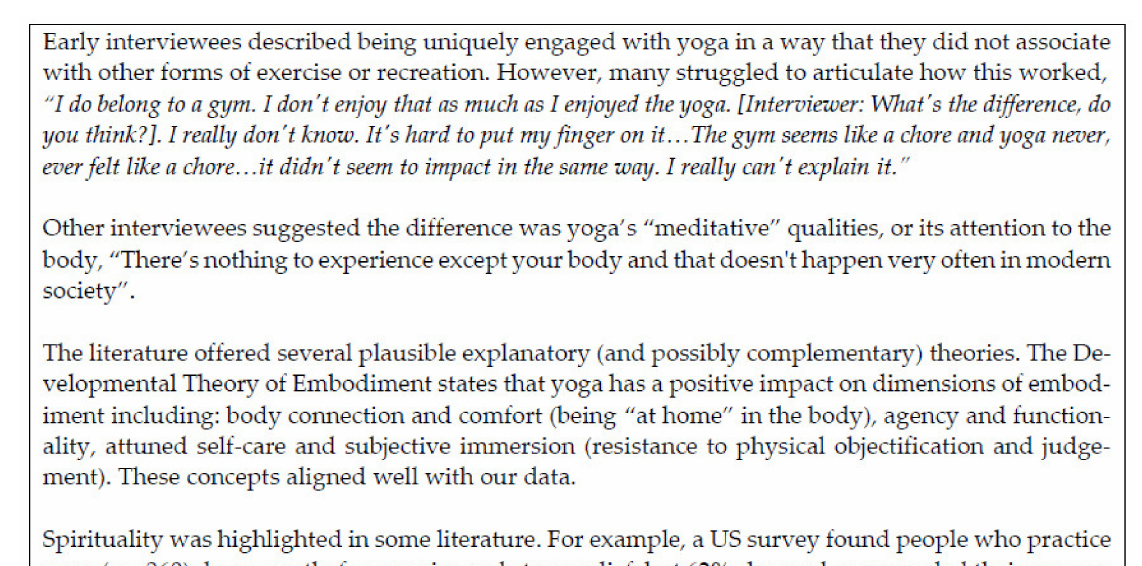
Figure 6. Using the Literature and Interviews to Develop a Theory